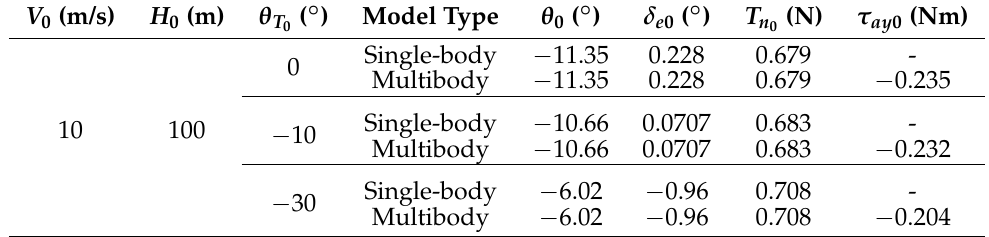
Table 2. Single-body vs multibody trim results at steady cruise trim condition.